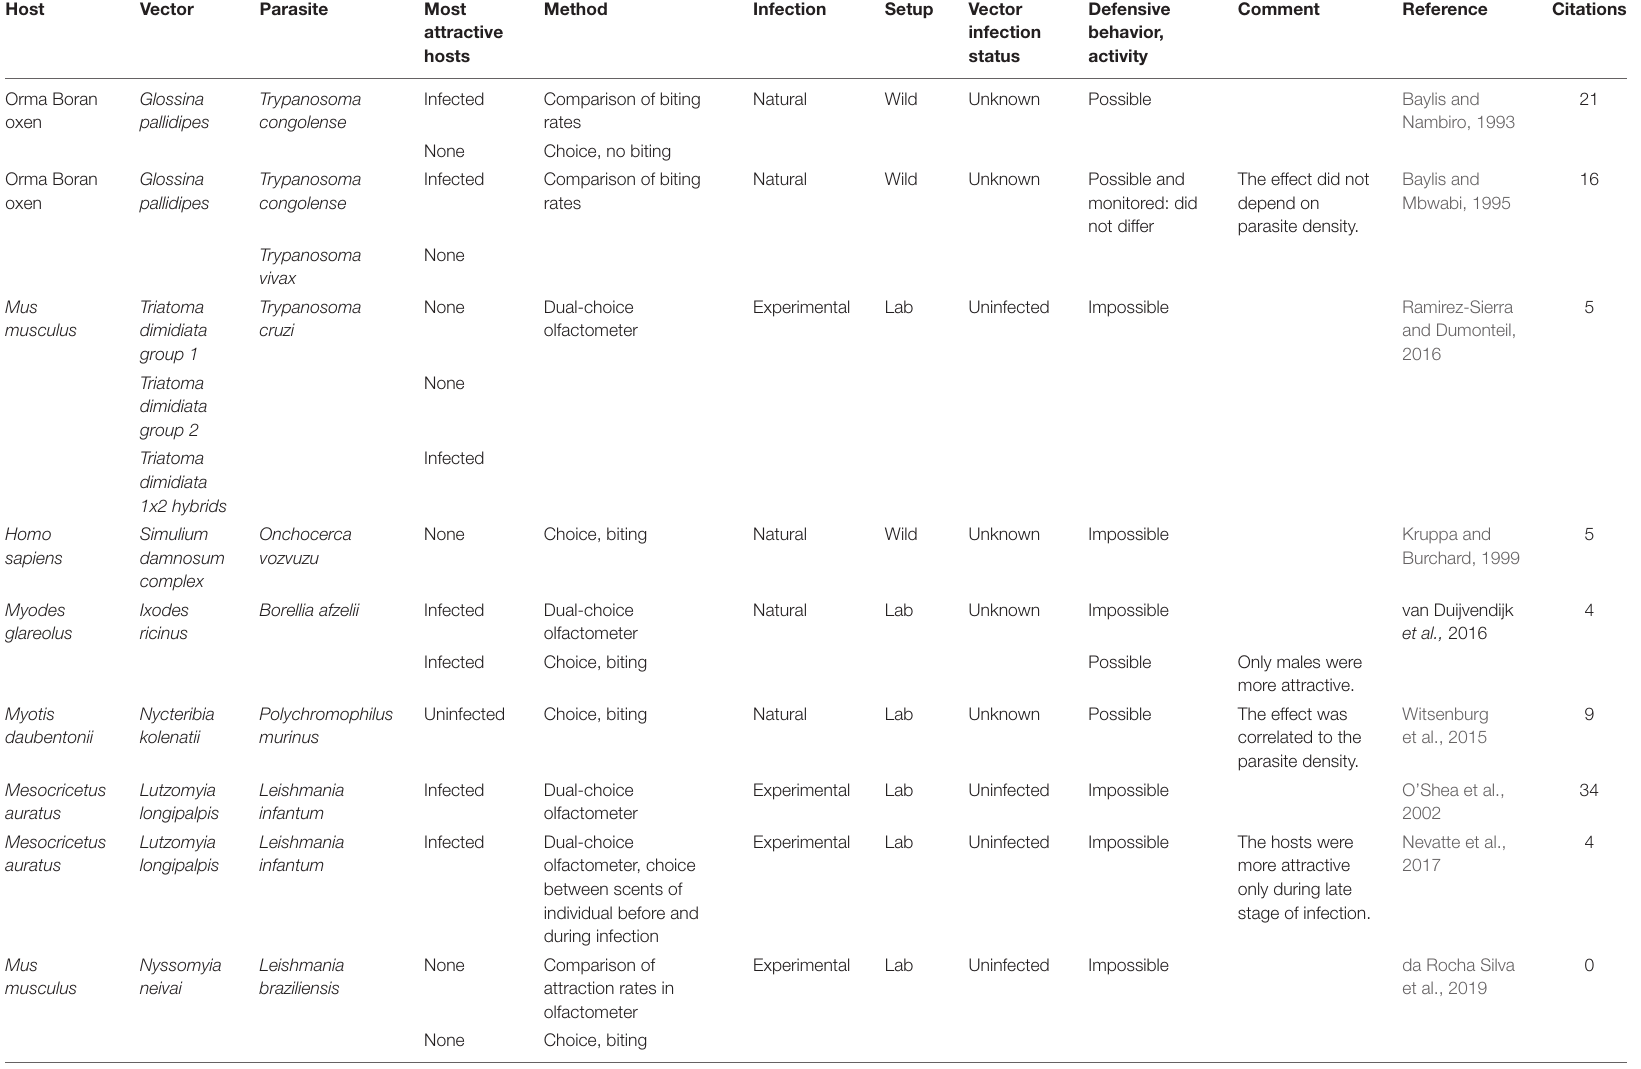
TABLE 2 | Summary of studies comparing attractiveness of infected and uninfected hosts to non-mosquito